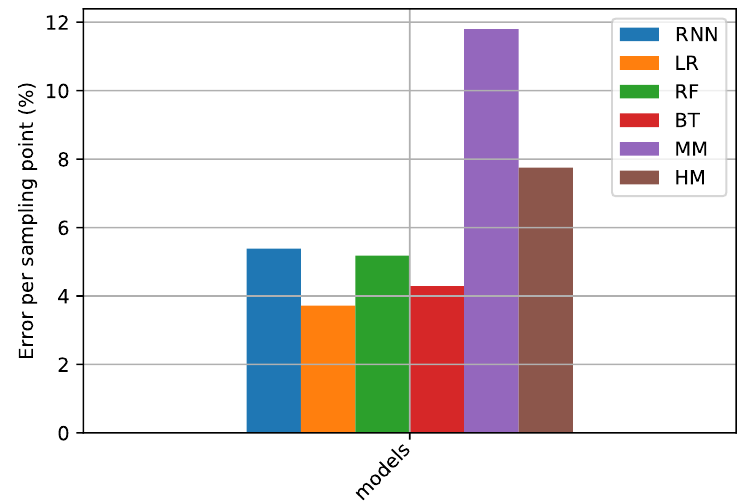
Figure 11. Model accuracy per sampling point in (%).